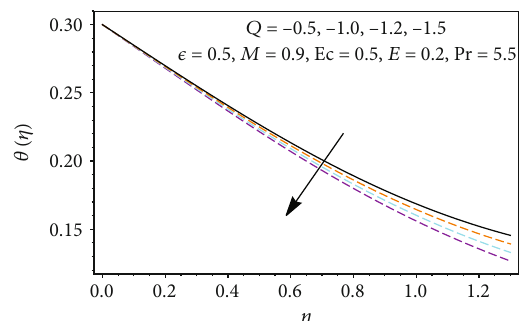
Figure 2: Illustration of the in fl uence of M on f ′ ð η Þ .